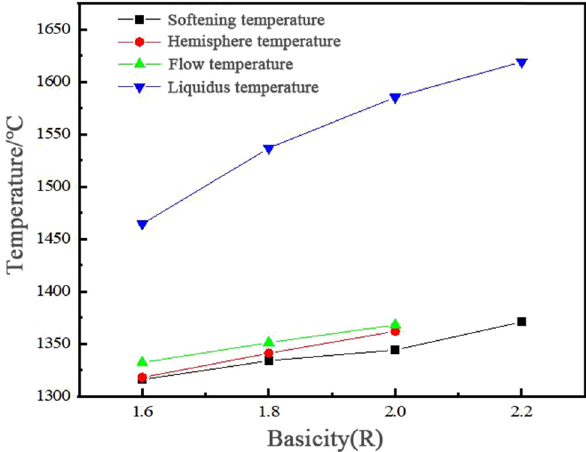
Figure 9: Melting properties of mixed slags with variable